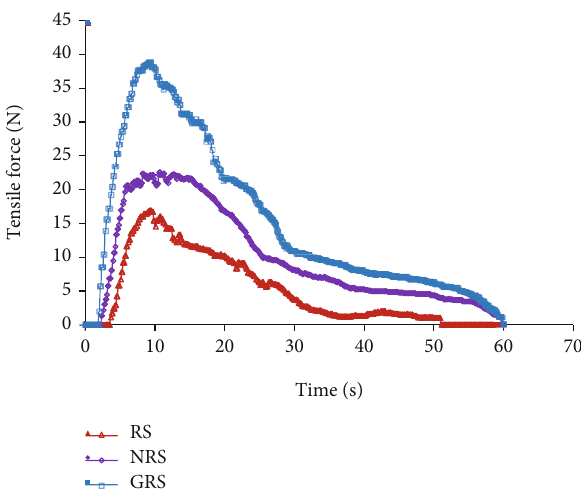
Figure 8: Root pulling time tensile curve under di ff erent interfacial bonding strength.